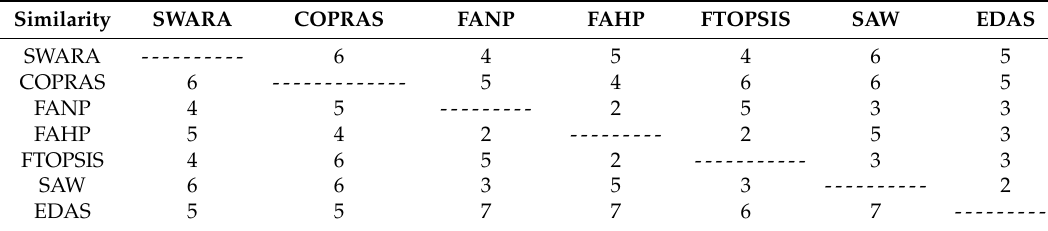
Table 6. Priority of alternatives determined using different MADM